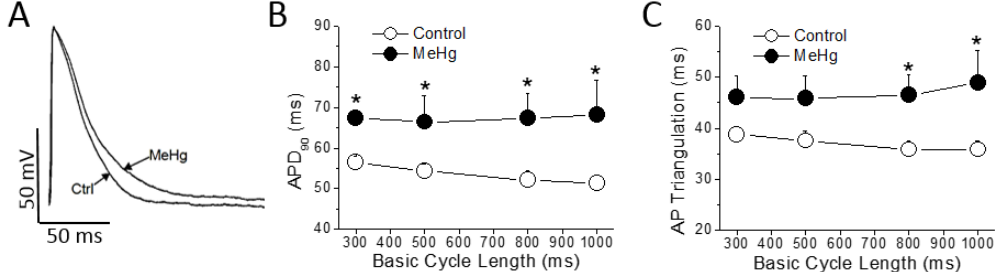
Figure 2. MeHg prolongs ventricular action potential duration. ( A ) ventricular action potentials were recorded in epicardial strips from control and MeHg-treated animals; ( B ) action potential duration at 90% of repolarization (APD 90 ) and ( C ) action potential (AP) triangulation at different basic cycle length (BCL), in control (open symbols) or after 4 weeks of treatment with MeHg (filled symbols). * p < 0.05. n = 7 control and 14 MeHg-treated hearts per group.